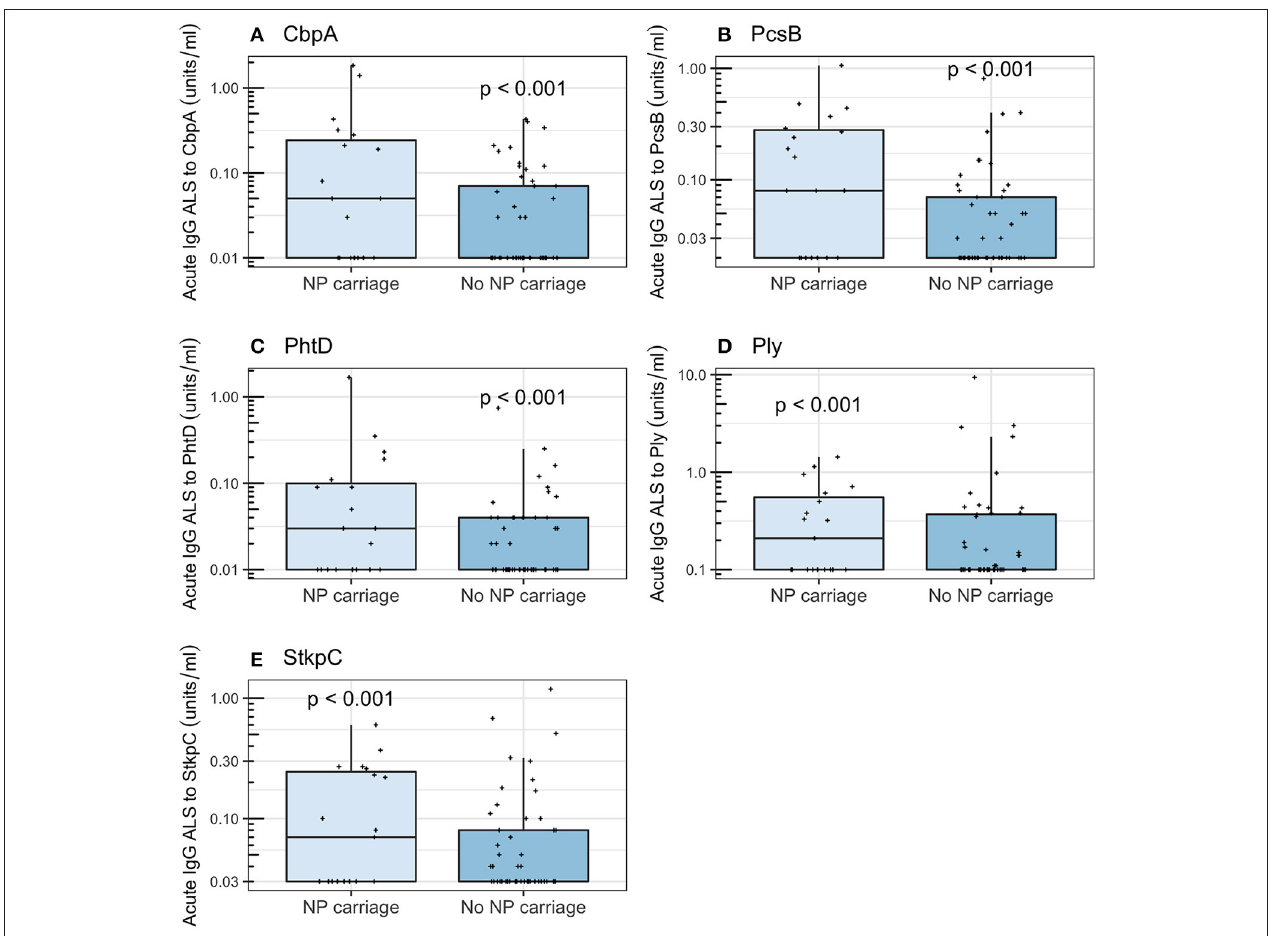
FIGURE 7 | Acute IgG ALS to pneumococcal proteins in children with non-pneumococcal pneumonia and NP carriage of pneumococci and without NP carriage of pneumococci enrolled into the study (all age groups). P -values were derived from the Wilcoxon rank sum test. (A) Choline binding protein A (CbpA); (B) protein for cell wall separation of group B streptococci (PcsB); (C) pneumococcal histidine triad D (PhtD); (D) pneumolysin (Ply); (E) serine threonine kinase protein C